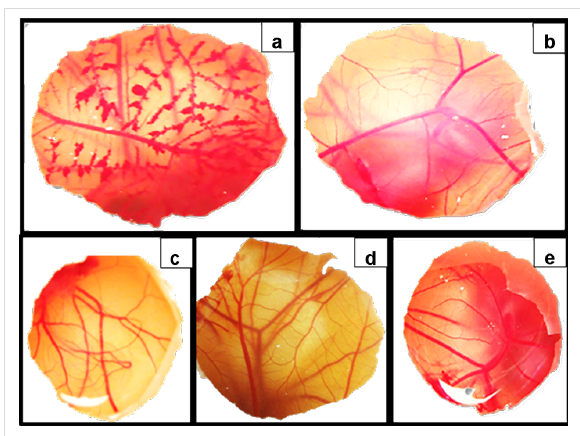
Figure 5: HET-CAM assay: (a) positive Control (NaOH 0.1 N); (b) negative control (NaCl 0.9%); (c) HPBCD 10 mg/mL; (d) SBECD 10 mg/mL; (e) fluconazole (2 mg/mL). Photographs show the status of the vessel at the end of the experiment.